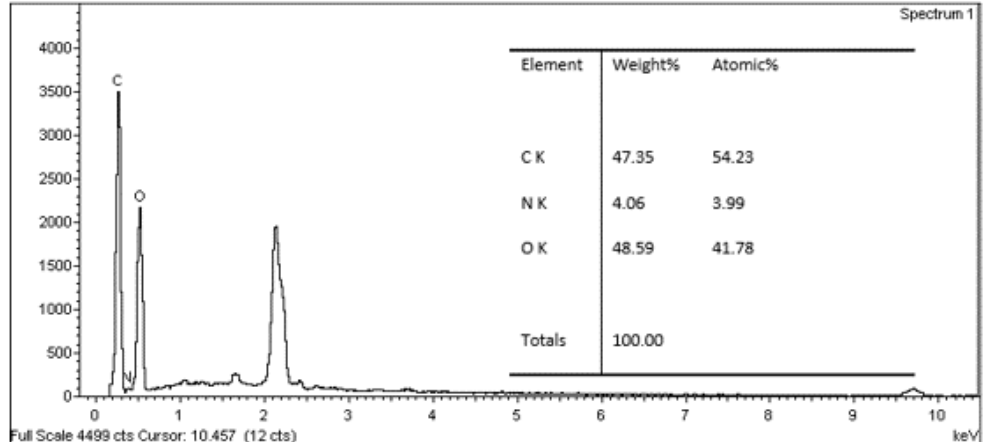
Figure 10. Energy dispersive X-ray spectrum for Rhizophora spp. particleboard bonded with 0% binders.